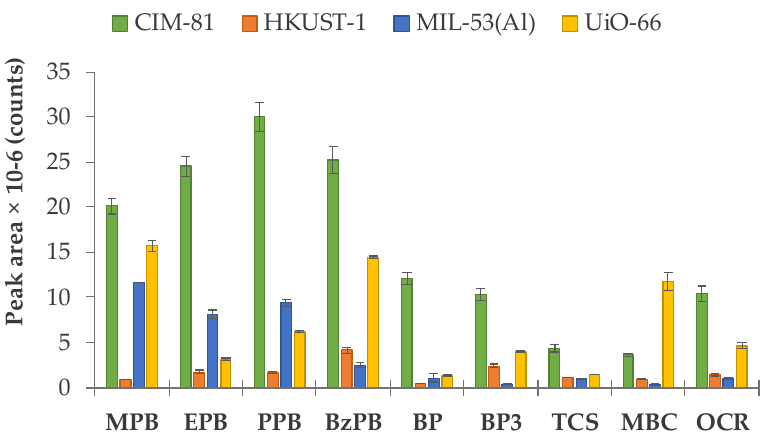
Figure 3. Evaluation of the extraction efficiency of PCPs using D-µSPE-UHPLC-UV and different MOFs as sorbents: CIM-81, HKUST-1, MIL-53(Al), and UiO-66; all used under the same extraction/desorption conditions (see text).